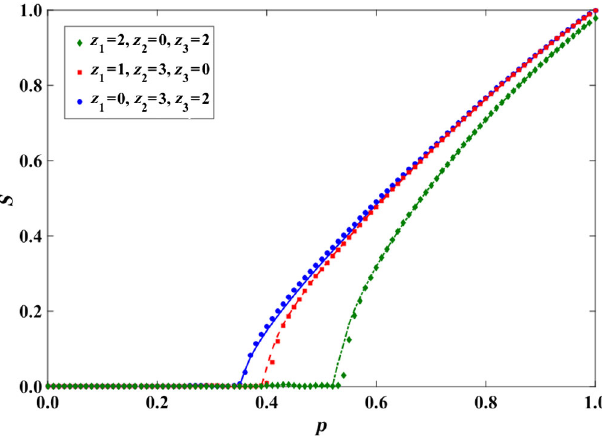
FIG. 9. Comparison between the simulation results of the RMCGC for a multiplex network with M ¼ 3 layers and Poisson multidegree distribution with h k ð 1 ; 1 ; 1 Þ i ¼ c 3 , h k ð 1 ; 1 ; 0 Þ i ¼ h k ð 1 ; 0 ; 1 Þ i ¼ h k ð 0 ; 1 ; 1 Þ i ¼ c 2 and h k ð 1 ; 0 ; 0 Þ i ¼ h k ð 0 ; 1 ; 0 Þ i ¼ h k ð 0 ; 0 ; 1 Þ i ¼ c 1 and the theoretic predictions over the same multilayer network ensemble. Data are shown for c 1 ¼ 0 , c 2 ¼ 3 , c 3 ¼ 2 (blue circles), c 1 ¼ 1 , c 2 ¼ 3 , c 3 ¼ 0 (red squares), and c 1 ¼ 2 , c 0 , c 2 (green diamonds). The theoretical predictions 2 ¼ 3 ¼ are indicated with lines. The simulation results are performed on multilayer networks with N ¼ 10 4 nodes and are averaged over 20 multilayer network